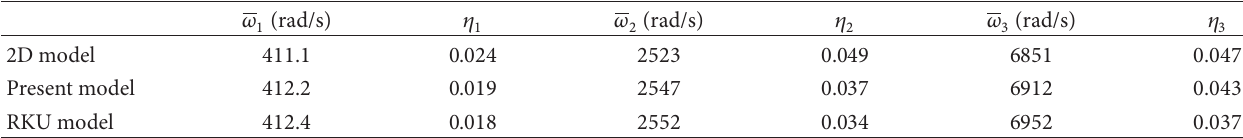
Table 2: Modal properties of the sandwich cantilever beam with 𝐻 2 = 1 mm.